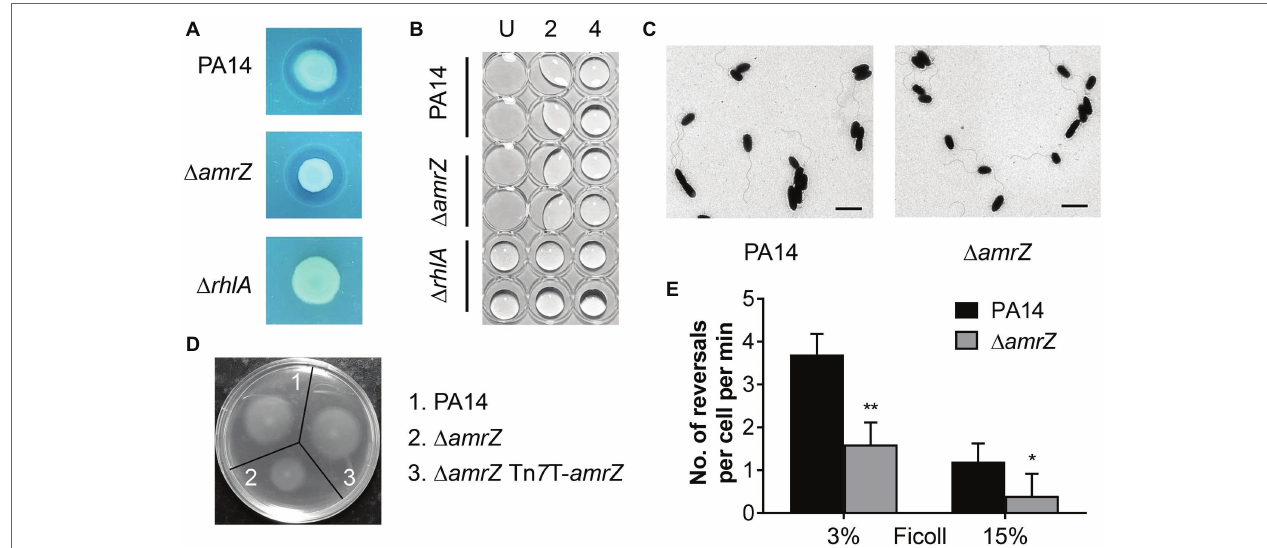
FIGURE 2 | The swarming defect of the amrZ mutant is independent of changes of biosurfactant production or flagellar formation but is associated with flagellar malfunction. (A) Methylene blue-rhamnolipid plate assay. The presence of surfactant is indicated by the formation of a dark ring surrounding a colony and the non-rhamnolipid-producing rhlA mutant served as a negative control. (B) Drop collapse analysis of PA14, ∆ amrZ , and ∆ rhlA mutants to detect the presence of the rhamnolipid precursor HAA. Samples were diluted in dH 2 O, spotted on the lid of a 96-well plate, and assayed for bead formation. The dilution factors are shown at the top. U, undiluted. (C) Morphology of PA14 and amrZ mutant cells by TEM of bacteria taken directly from swarm plates. Bar, 2 μm. (D) Swimming motility assay of the indicated strains. (E) Flagellar reversal rates under low (3% Ficoll) and high-viscosity (15% Ficoll) conditions, representing swimming and swarming conditions, respectively, were measured as changes in direction of movement of cells. Rates are expressed as number of reversals per cell per minute. Error bars represent the standard deviations. * p < 0.05; ** p < 0.01 compared with WT by Student’s t